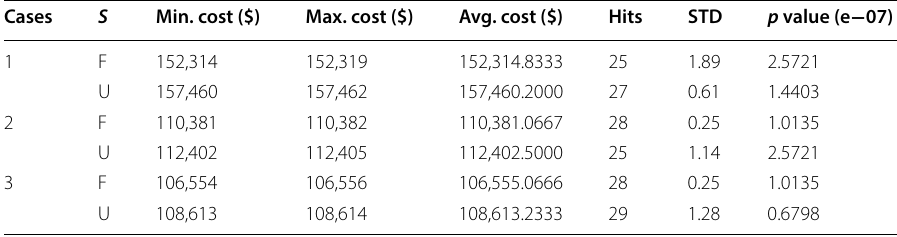
Table 5 Statistical analysis of MGWOSCACSA